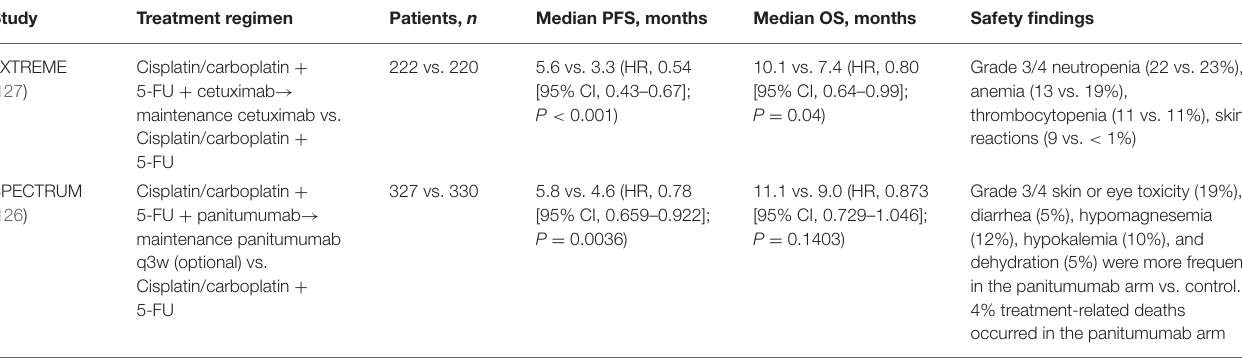
TABLE 5B | Clinical impact of cetuximab and panitumumab in R/M SCCHN.